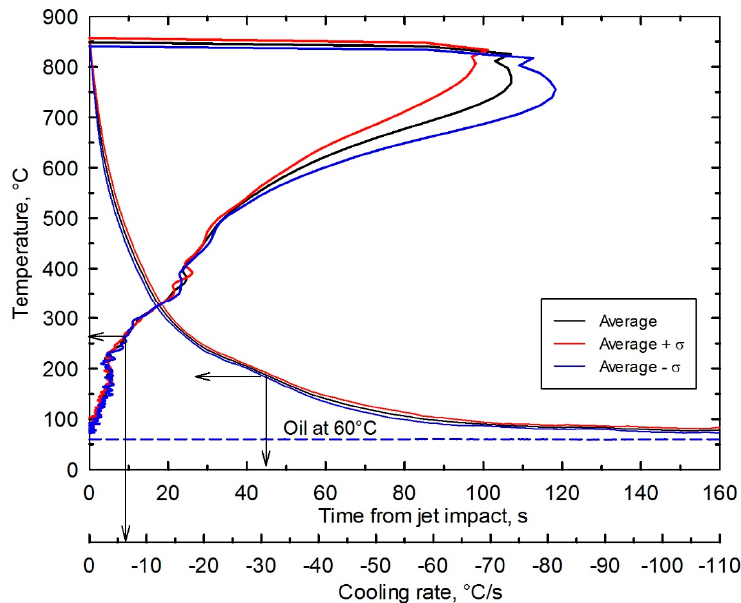
Figure 6. Average thermal evolution and its corresponding cooling rate obtained from oil-quenching laboratory experiments. Impact oil velocity and oil temperature were 0.9 m/s and 60 °C, respectively. A 95% confidence interval is indicated for both curves, temperature and cooling rate.